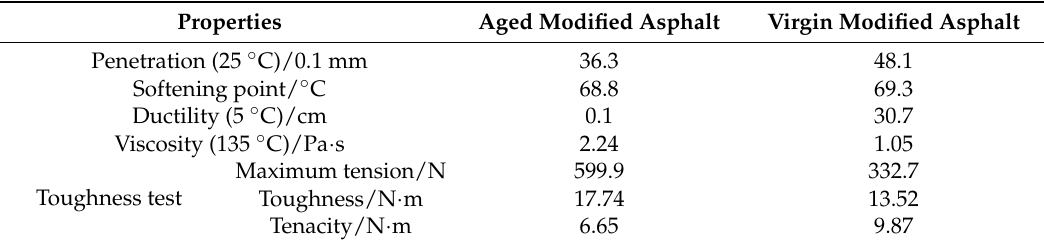
Table 1. Main properties of modified